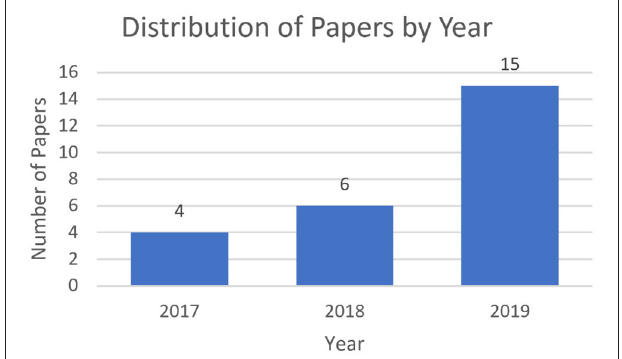
FIGURE 4 | Distribution of surveyed papers by year, indicating an increase of academic interest in this area.